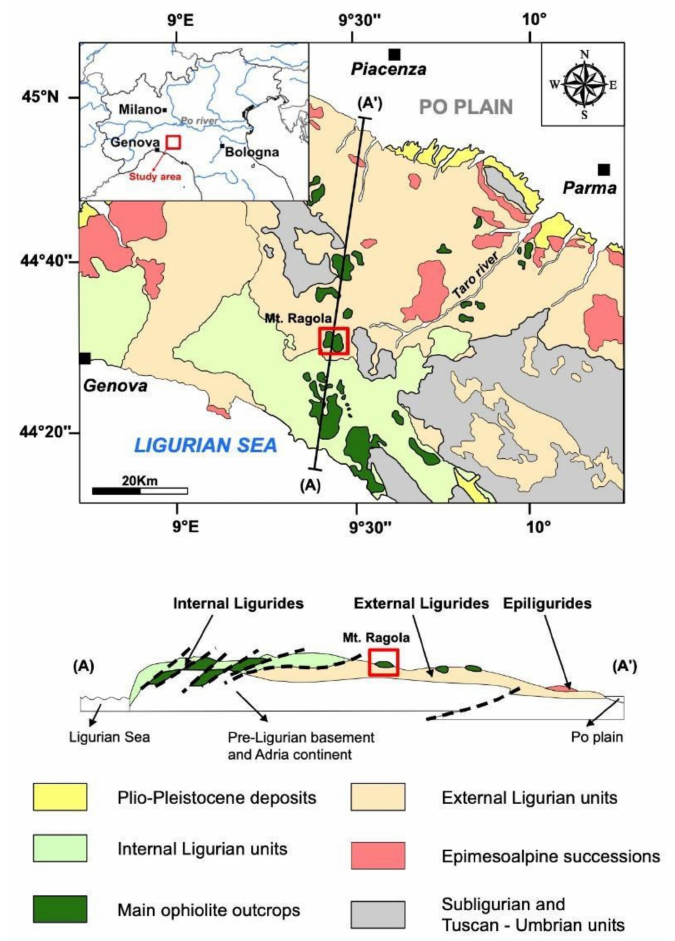
Figure 1. Tectonic sketch map and geological cross-section of the Northern Apennines (modified from [2]) with location of the study area (red